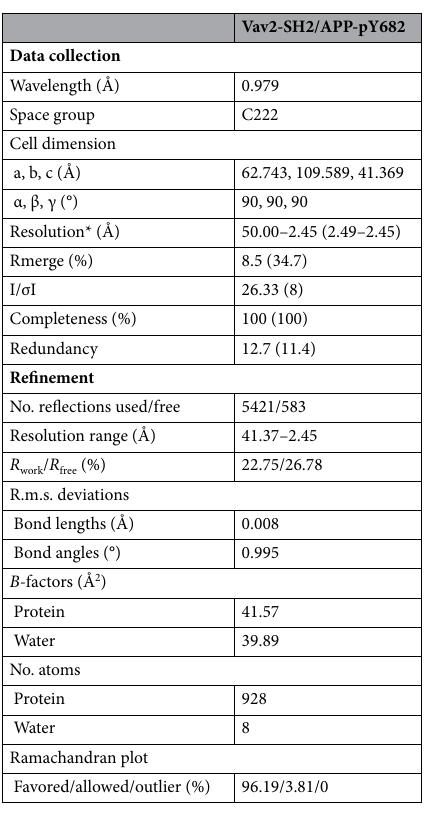
Table 1. Data collection and refinement statistics.